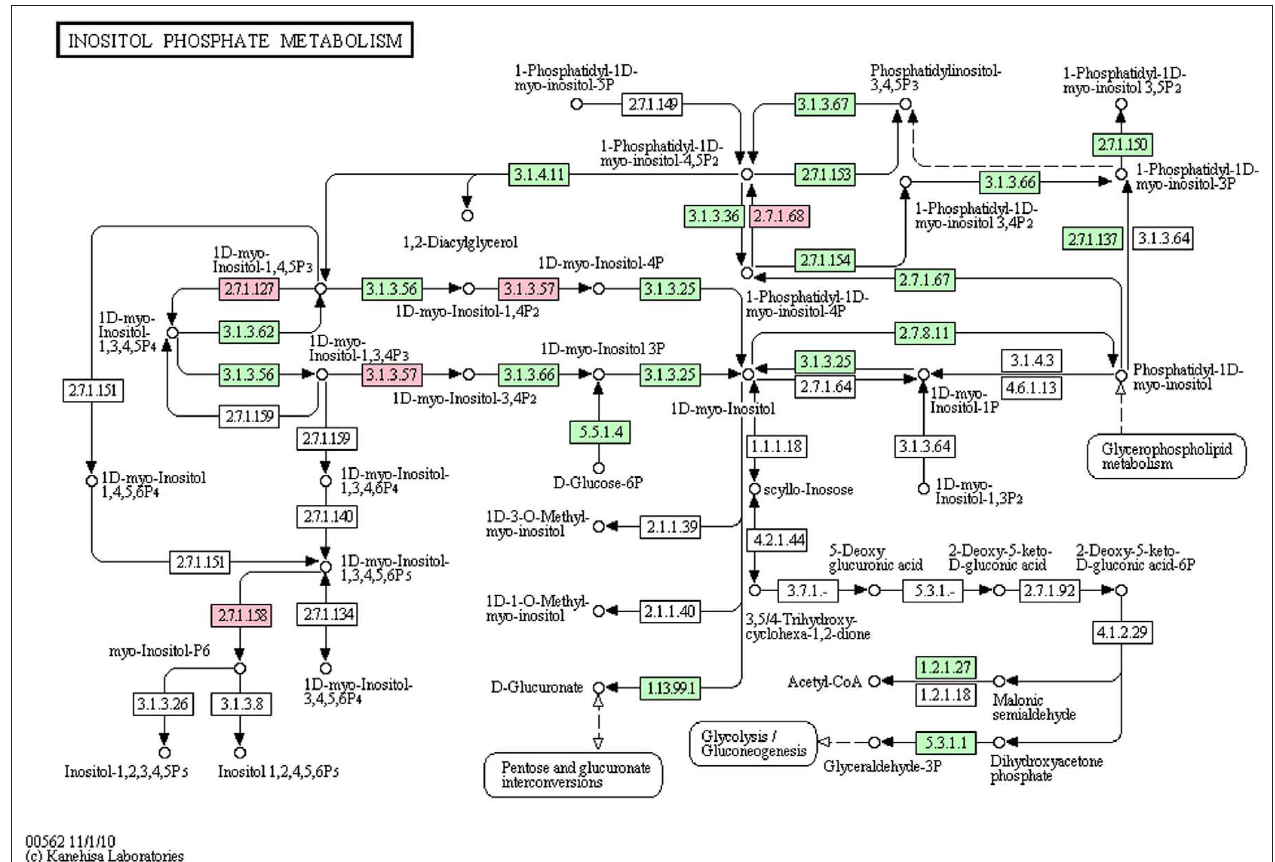
product from transcript CG30295-RB), Ipp (Inositol polyphosphate 1-phosphatase), and PIP5K59B (CG3682 gene product from transcript CG3682-RA). Green boxes represent other members in the pathway database for Drosophila melanogaster